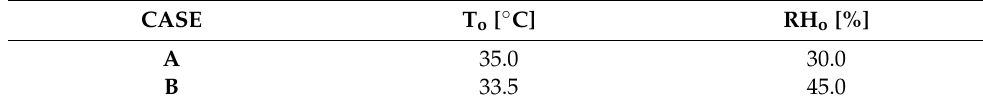
Table 1. Outdoor air conditions assumed in the simulations.